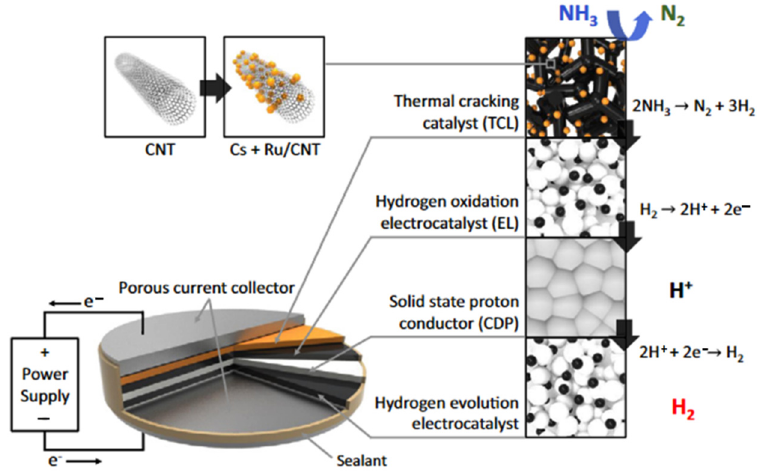
Figure 40. Schematic of ammonia-to-hydrogen conversion by the hybrid thermal–electrochemical cell. Reprinted with permission [53].